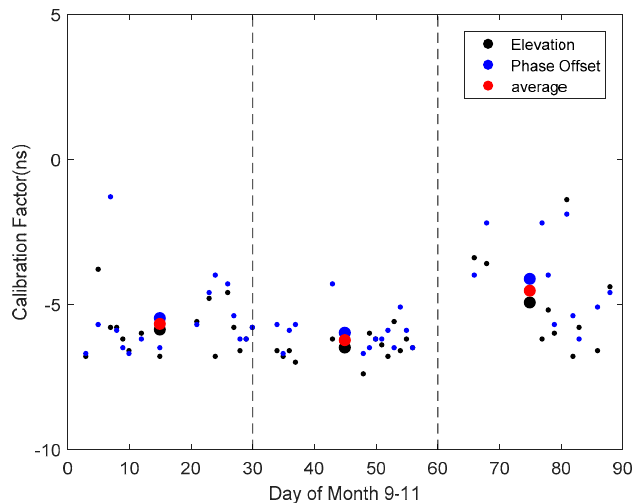
Figure 6. Number of echoes between the phase deviation and the group range from Zhongshan radar on 27 September 2013. The solid black line represents the theoretical relationship between the phase deviation and the group range when the virtual height is 520 km. ( a ) the original (uncalibrated) data; ( b ) data calibrated with ∆ t cor = − 5.93 ns. The data shown in Figure 6 show that the calibration factor ∆ t cor obtained by the phase offset verification is consistent with the elevation–virtual height model. Figure 7 shows the comparison of ∆ t cor determined by the two algorithms from September to November 2013. The black and blue dots are the daily calibration factors obtained by using the elevation angle and the phase offset, respectively. The black and blue solid circles correspond to the monthly mean calibration factors obtained by the daily calibration factors. There are some days with no data, which results in there being not enough ground echoes to calibrate. ∆ t cor is mostly concentrated between − 5 and − 7 ns, and the estimated values of the difference of two algorithms are generally less than 1 ns. The red solid circle is the mean value of the two methods, which is − 5.68 ns, − 6.24 ns, and − 4.54 ns from September to November, respectively.